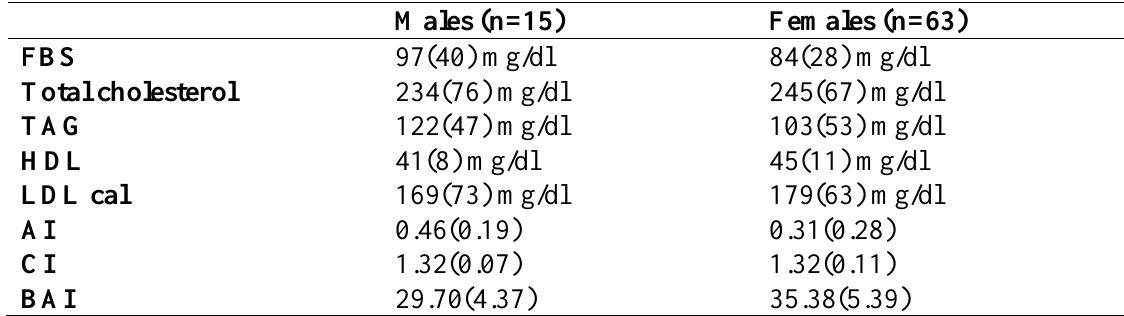
Males (n=15) Females (n=63)